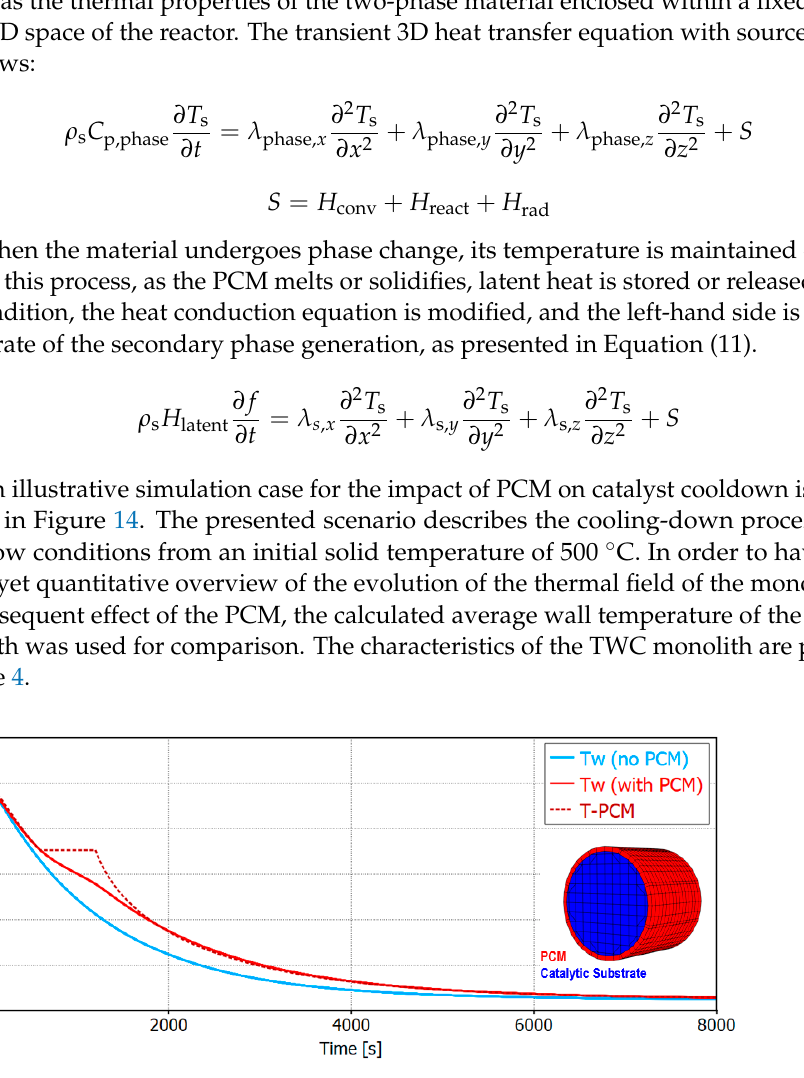
Figure 14. Impact of PCM on catalyst temperature during a cooling-down process under zero flow conditions. Table 4. Characteristics of the test monolith.